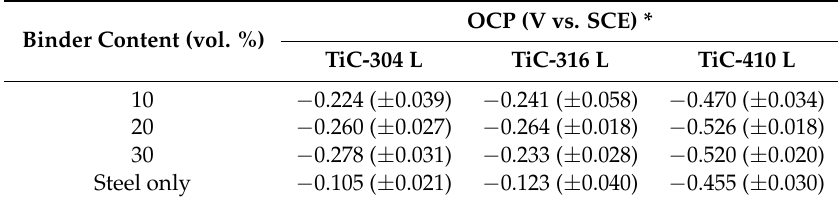
Table 2. Open circuit potential (OCP) values determined for the cermets as a function of the steel binder content. Each value is the mean of 10 repetitions. Binder Content (vol. %)